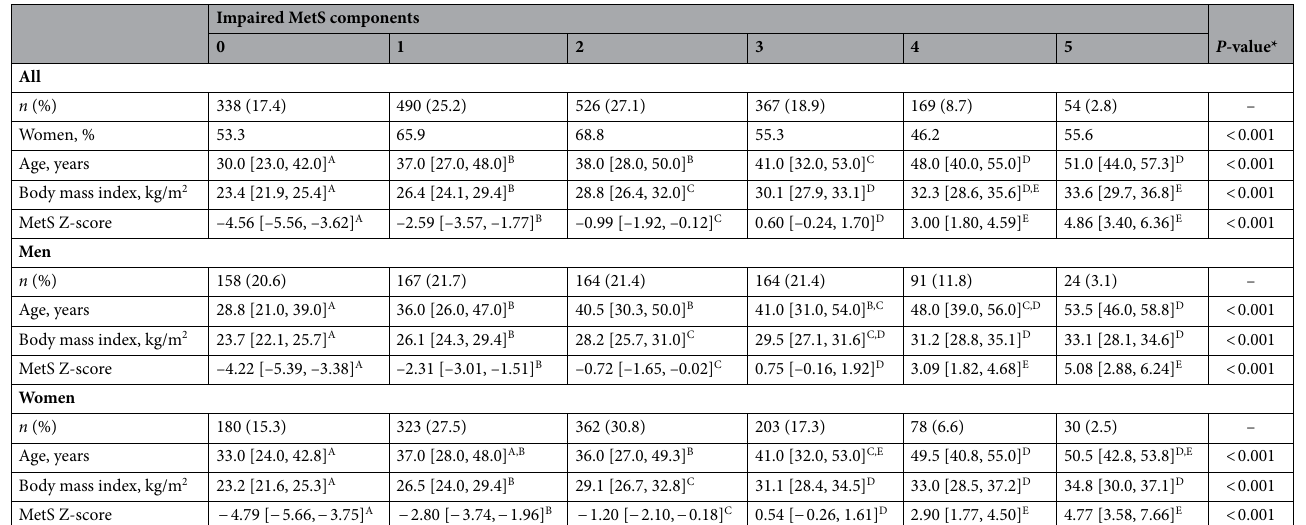
Table 2. Characteristics of the subjects by groups of metabolic syndrome (MetS) components. Values are frequency (percentage), percentage, or median [25th percentile, 75th percentile]. *Pearson Chi-Square, or Independent-samples Kruskal–Wallis. Different superscripts indicate differences between groups in the pairwise post-hoc tests ( P -value <